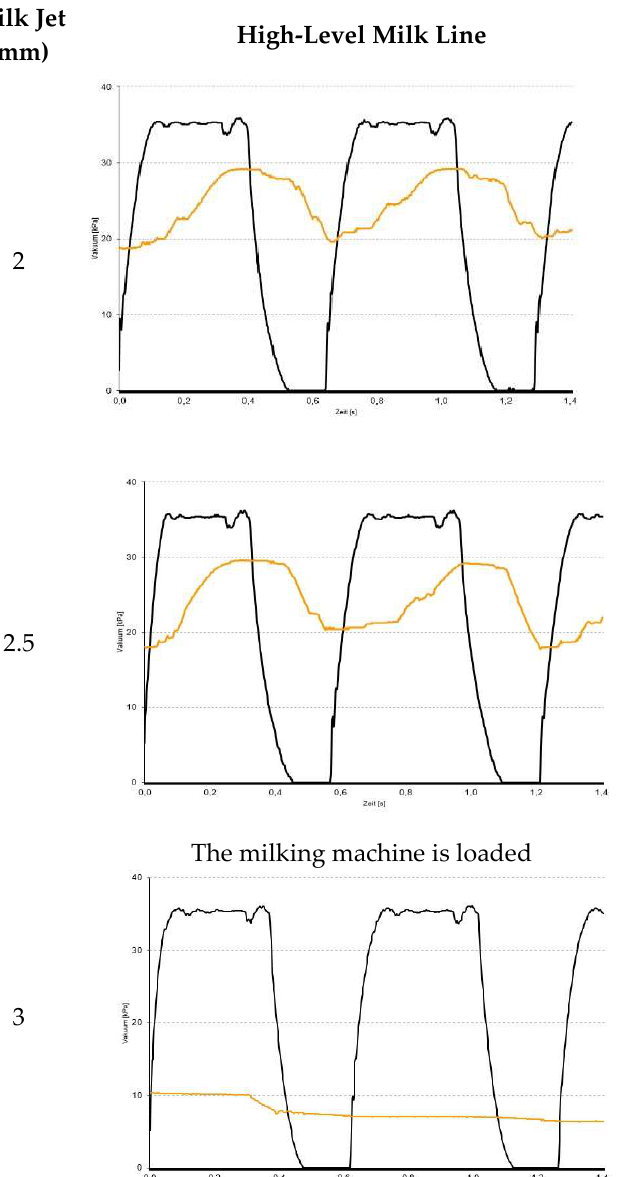
Figure 5. Cyclical vacuum fluctuations in the pulsation and inner chambers of the teat cup during the 1st WF in the goat milking machine, with the following settings: 34 vacuum level (kPa), 90 pul- sation rate (cycles/min) and 60:40 pulsation ratio.